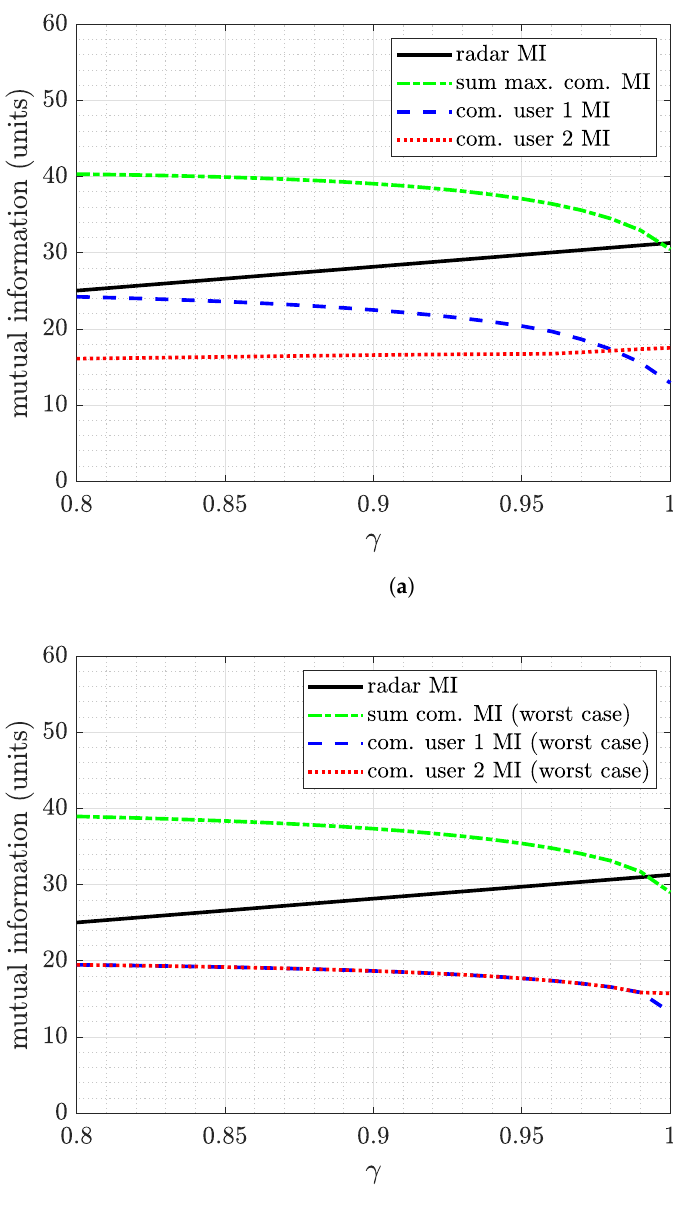
Figure 9. Cooperative power allocation for varying γ using chunk subcarrier allocation. ( a ) Sum communication MI maximization. ( b ) Worst-case communication MI